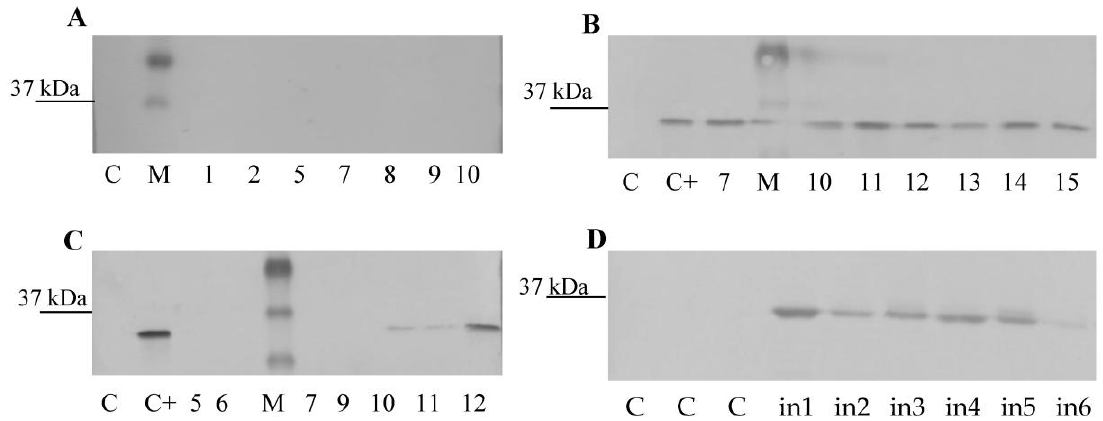
Figure 6. Western blot analysis of transgenic chrysanthemum lines with different resistance to CVB. ( A ) Transgenic line pRNAIVB5. ( B ) Transgenic line pRNAIVB18. ( C ) Transgenic line pRNAIVB4. ( D )Non-transformed control plants after infection. The numbers denote the plants of the studied lines.